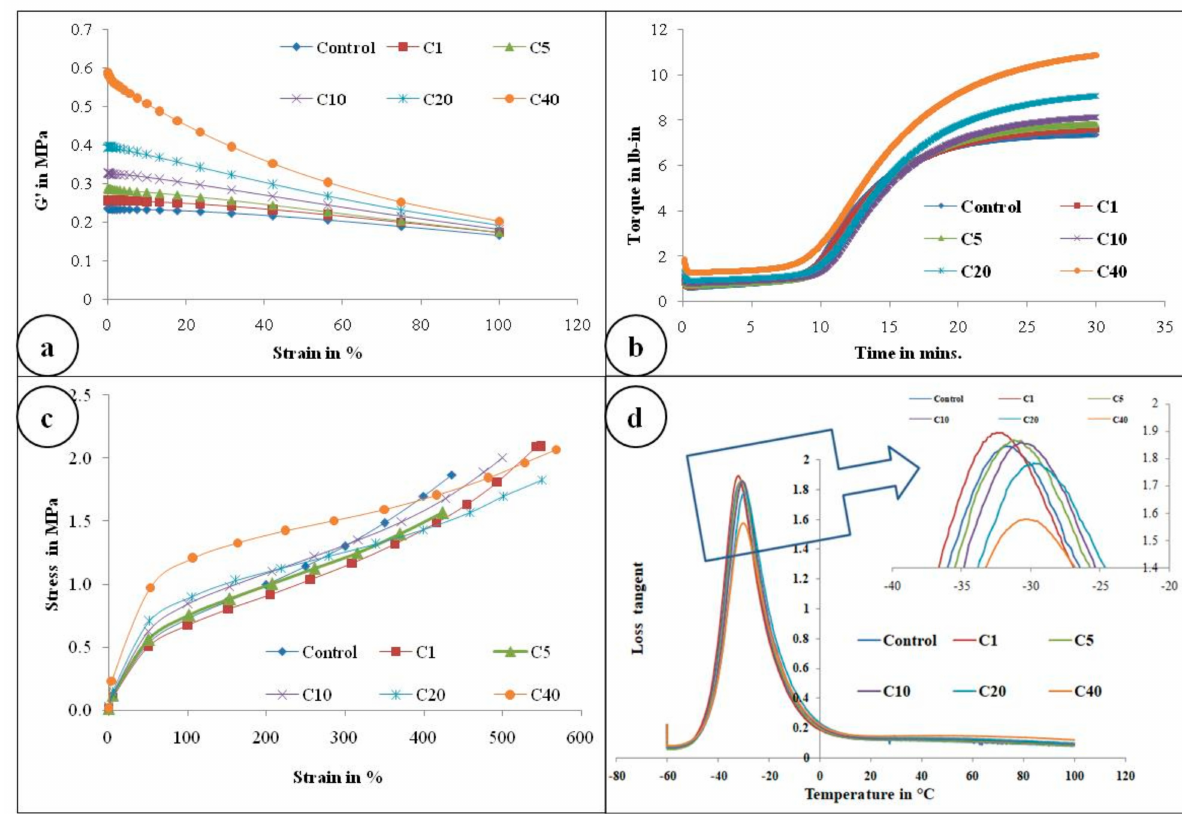
Figure 4. ( a ) Payne effect measurement, G’ (in Pa) against % strain; ( b ) rheological graph of all compounds; ( c ) stress–strain curve of all compounds; ( d ) Plot of tan δ with respect to temperature scan( − 60 to +100 ◦ C) of all compounds (Inset: Magnified view of tan δ